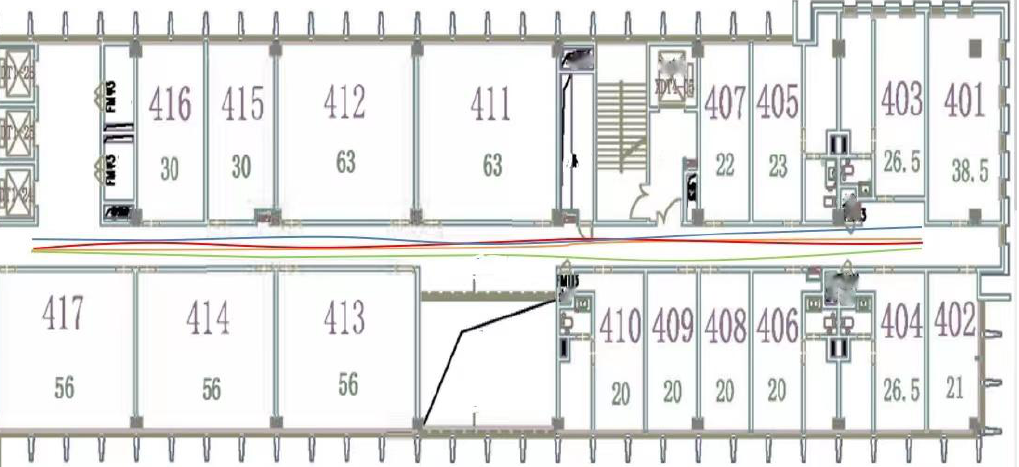
Figure 8. CDF of localization errors for different localization methods.